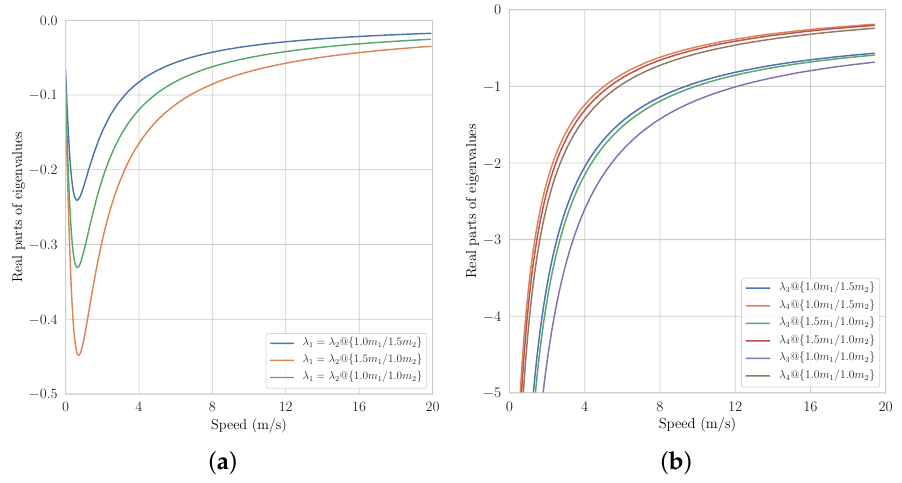
Figure 8. Variation of the real parts of the eigenvalues with the vehicle mass: ( a ) real parts of λ 1 and λ 2 and ( b ) real parts of λ 3 and λ 4